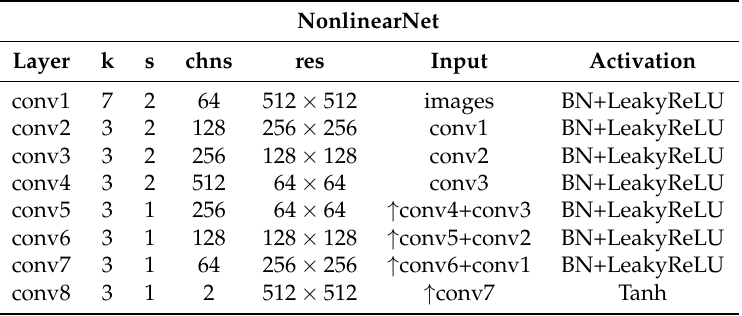
Table 2. NonlinearNet architecture. Here k is the kernel size, s is the stride, chns is the number of output channels for each layer, res is the input image resolution, and input corresponds to the input of each layer where ↑ is a 2 × nearest-neighbor upsampling of the layer, conv* denotes convolutional layer, deconv* denotes transpose convolutional